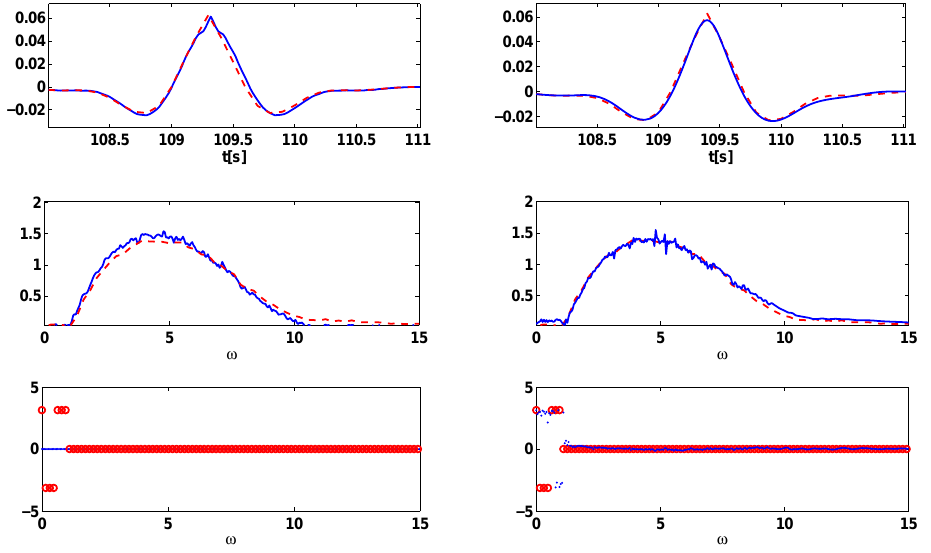
Fig. 9. We show in the left column the comparison between properties for the linear (solid) and the nonlinear maximal signal (dashed), and in the right column a comparison between properties of the nonlinear maximal signal (solid) and AB-simulations started at X = 10m of the signal at X = 50 . 2m (dashed). In the upper row for the signals, in the middle row for the spectrum, and in the lower row for the phase.